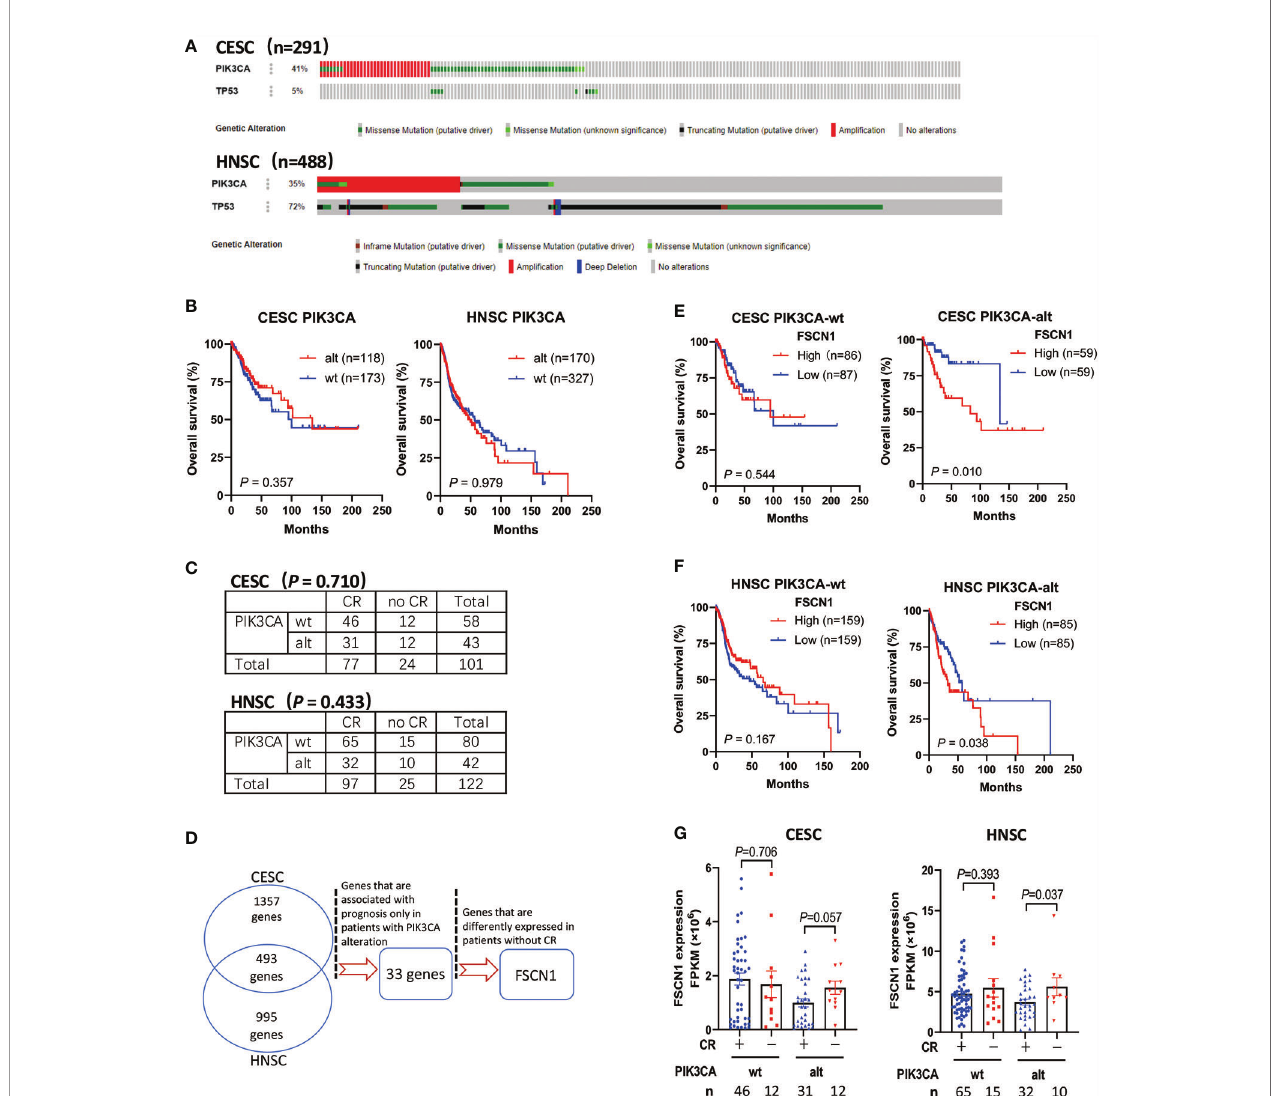
FIGURE 1 | High expression of FSCN1 is associated with poor prognosis and response to radiotherapy in CESC and HNSC patients with PIK3CA alterations. (A) The frequency of PIK3CA gene alterations in cervical cancer (CESC) and head and neck cancer (HNSC) cases from the cBioPortal database. (B) Kaplan – Meier curve shows the overall survival (OS) rate in CESC and HNSC cases from the TCGA cohort with wild-type PIK3CA or altered PIK3CA. The P values were calculated by log-rank test. (C) The table shows the radiotherapy response in CESC and HNSC with wild-type PIK3CA or altered PIK3CA. (D) The work fl ow of screening genes that have synthetic lethal interactions with PIK3CA using TCGA Data Portal. (E, F) Kaplan – Meier curve shows that the overall survival (OS) rate was signi fi cantly lower in the high FSCN1 group with PIK3CA activation in the TCGA cohort. The median FSCN1 level was chosen as the cut ‐ off value for separating the FSCN1 high ‐ level and low-level groups. (G) The expression of FSCN1 in different CESC and HNSC patient groups with or without a complete response to radiotherapy. PIK3CA “ wt ” or “ alt ” , PIK3CA wild type or altered (mutated or ampli fi cated); “ CR ” or “ no CR ” , complete response or no complete response. Data are presented as